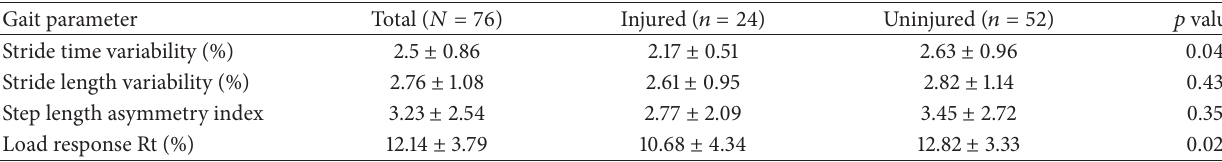
Table 2: Gait parameters means and standard deviations (M ± SD).